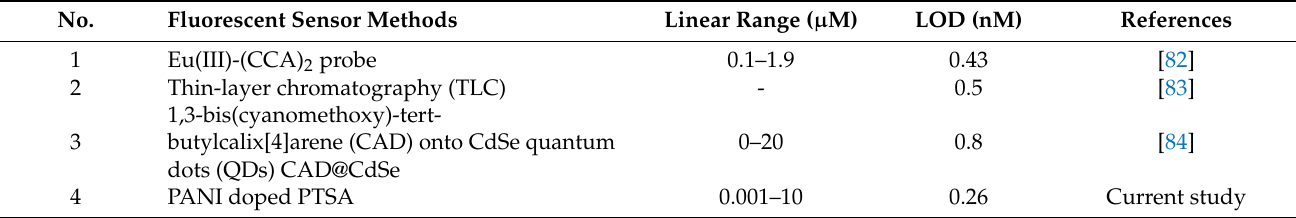
Figure 9. ( a ) Excitation photoluminescence peaks. ( b ) Emission photoluminescence peaks of fluorene in concentrations of 0.001, 0.01, 0.1, 1 and 10 µ M upon interaction with PANI*. ( c ) Variation of intensity peaks when PANI* interacted with fluorene. Table 8. Comparison of fluorene sensors with different detection techniques according to fluorescence obtained during experimental measurements.